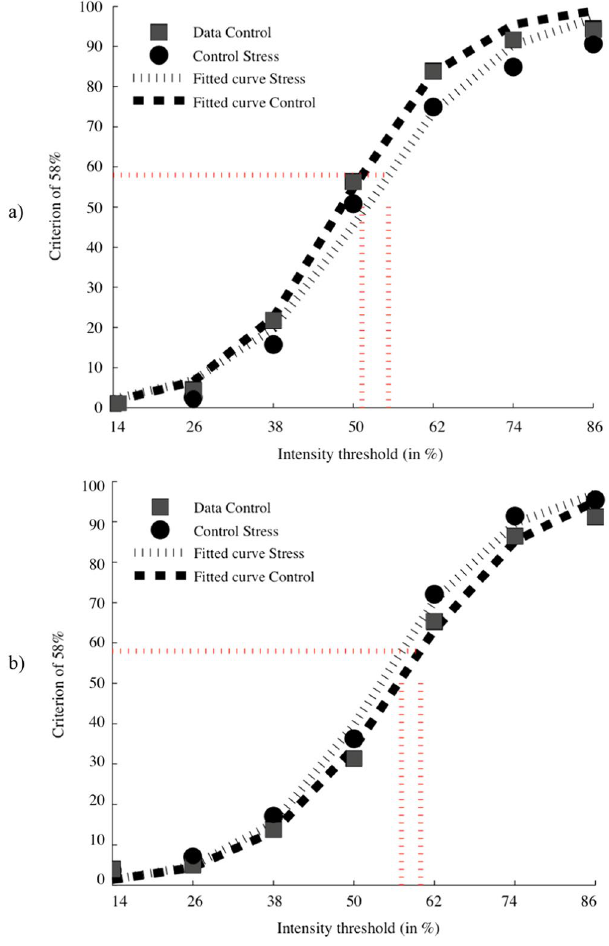
Figure 4. Intensity threshold between experimental conditions for ( a ) the expression of disgust and ( b ) the expression of